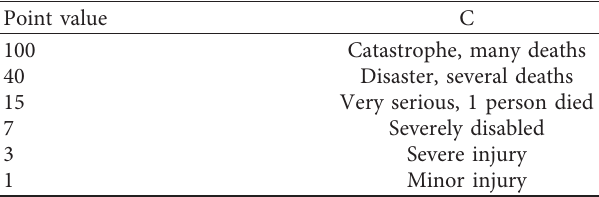
Table 3: The severity of the consequences of the accident (C).